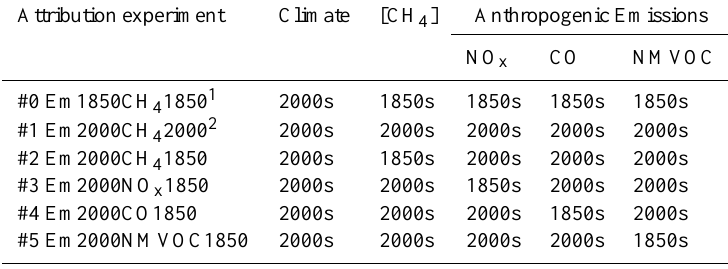
Table 6. Attribution